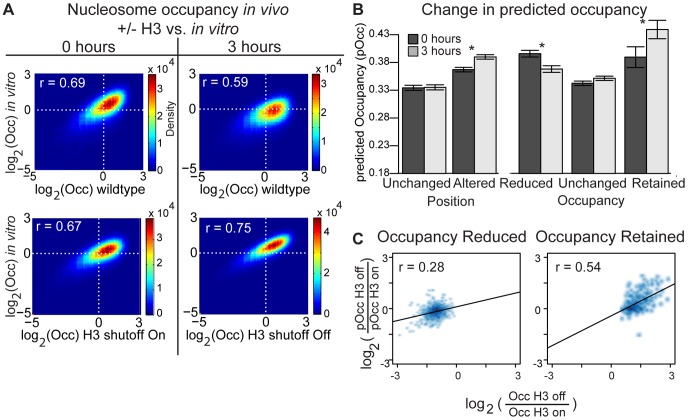
DNA sequence contributes to nucleosome occupancy changes following H3 depletion.(A) In vivo nucleosome occupancy versus previously published in vitro nucleosome occupancy genome wide [8]. The occupancy values were normalized as in [8], and log2 values are plotted. (B) Changes in the DNA sequence-based predicted occupancy (“model score” from [8]) at nucleosomes in the indicated categories at the 0 hour (dark gray) and 3 hour (light gray) nucleosome positions. The error bars indicate the standard error, and pairs marked with an * are significantly different at a p-value<0.001. (C) The degree of nucleosome occupancy reduction or retention following H3 depletion correlates with the DNA-sequence based predictions of change in nucleosome occupancy. Nucleosomes classified as “occupancy reduced” or “occupancy retained” are plotted. Because a position change is required for an alteration in predicted occupancy, nucleosomes classified as “position unchanged” were not included. pOcc = Occupancy prediction from [8]; Occ = occupancy in H3 shutoff strain.